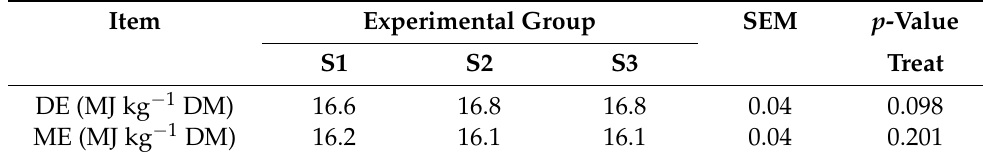
Table 4. Effects of sorghum conserves with varying dry matter concentrations (701, 738 and 809 g kg − 1 ) on the concentrations of digestible energy and metabolizable energy in diets for growing pigs ( n =